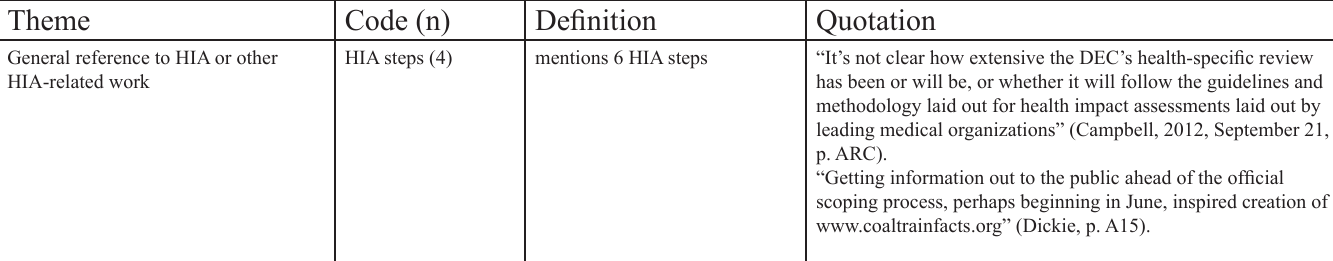
Table 2. Definitions and illustrative quotations for each code, categorized by theme